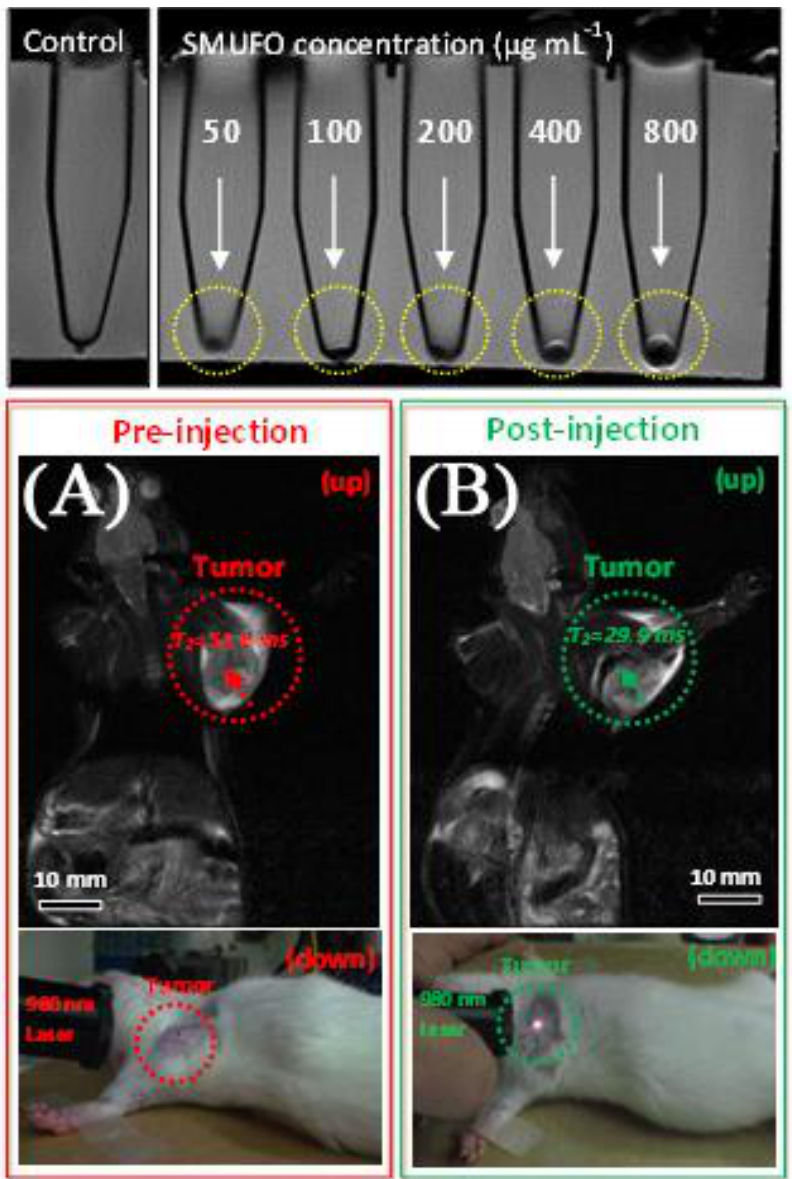
Figure 17. Top: sensitivity of in vitro MRI of SMUFO treated MCF-7 cells at different concentrations. Bottom: in vivo MR and upconversion fluorescence bimodal imaging of Walker 256 tumor using SMUFO. In vivo whole body pre-injection ( A ) and post-injection ( B ) MRI of mouse bearing a Walker 256 tumor. Pre-injection image (A bottom) and post-injection image (B bottom) of the upconversion fluorescence imaging of tumor in vivo using NIR laser ([115,125], reproduced by permission of